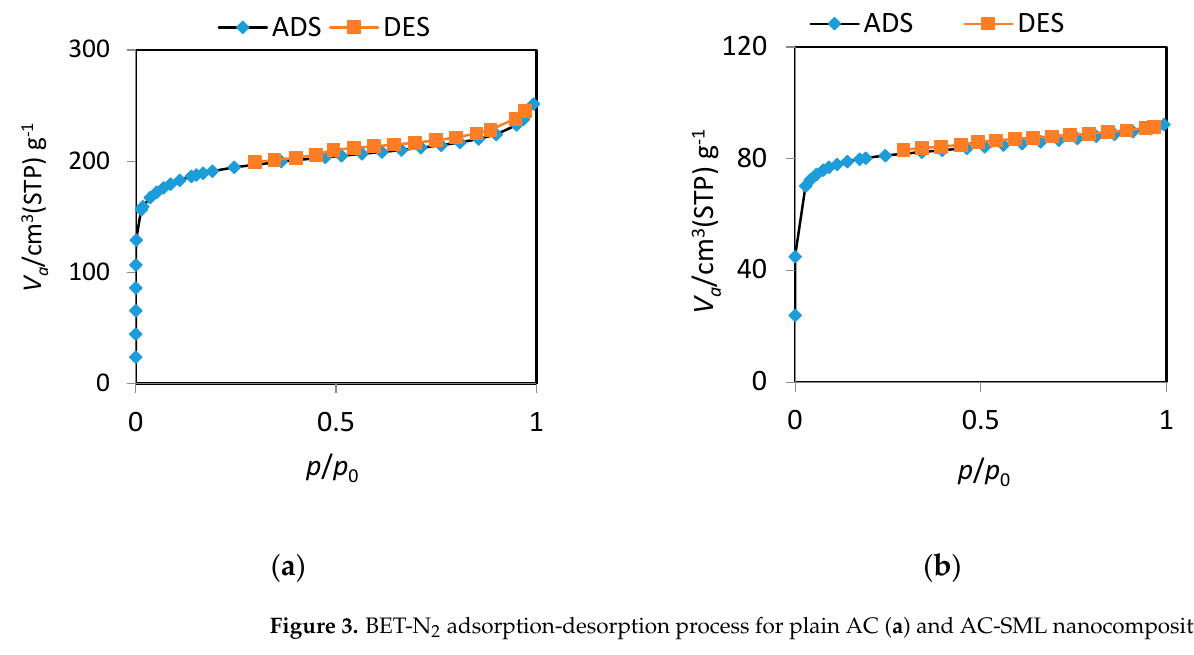
Figure 3. BET-N 2 adsorption-desorption process for plain AC ( a ) and AC-SML nanocomposite ( b ).